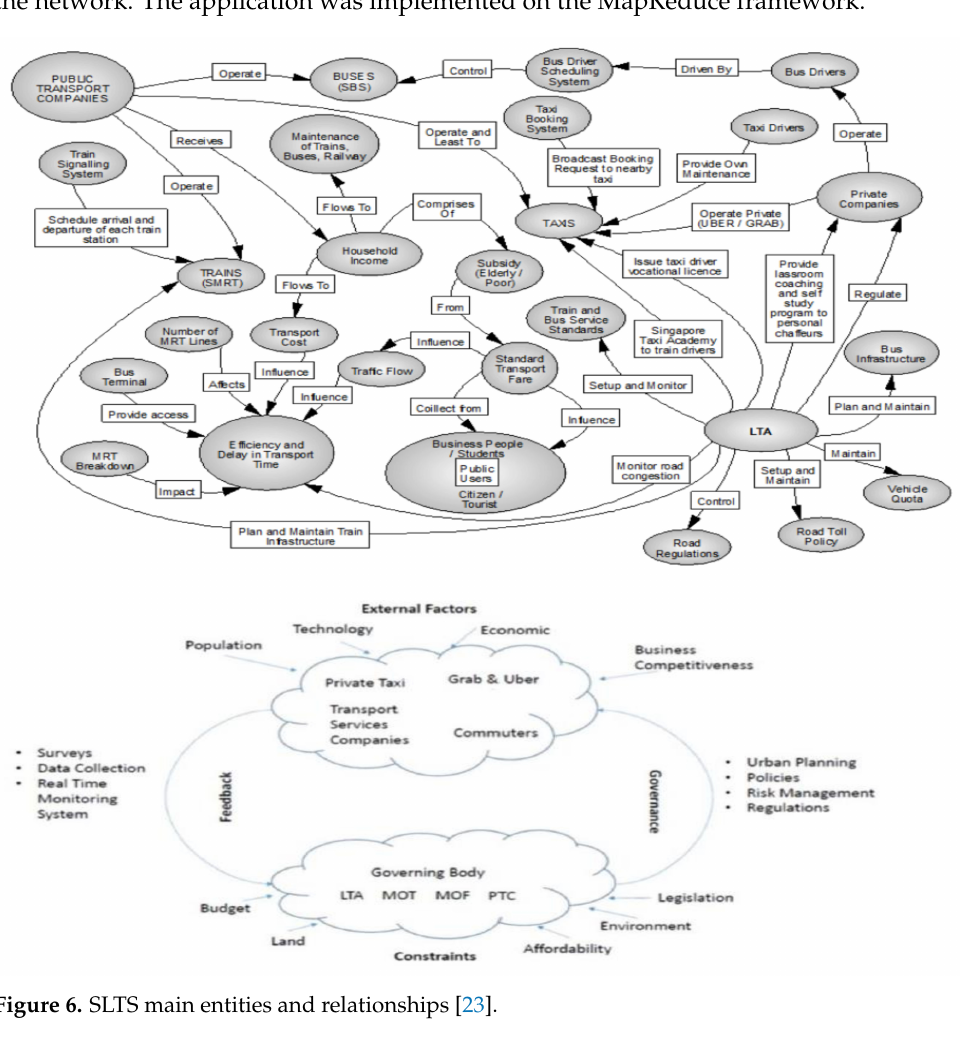
Figure 6. SLTS main entities and relationships [23].